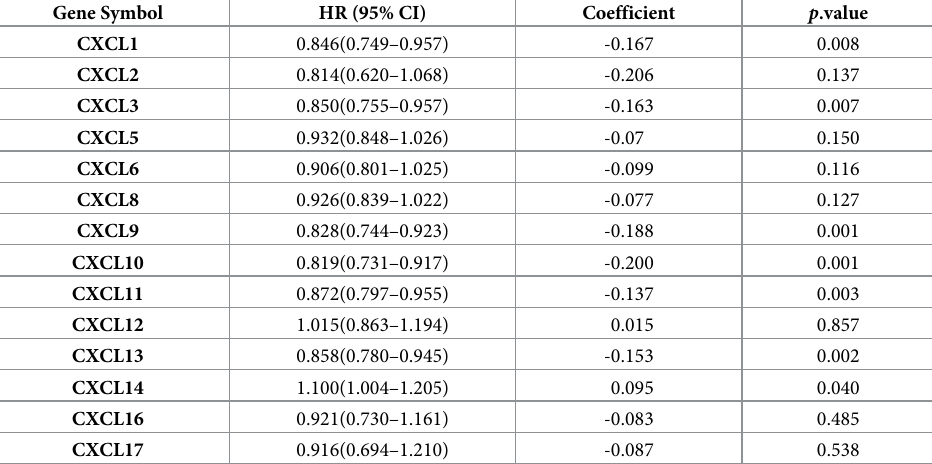
Table 1. Univariate Cox regression analysis of CXC subfamily ligands associated with disease-free survival in dataset GSE39582 (n = 491). Gene Symbol HR (95%